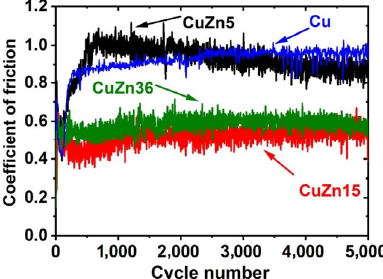
Fig. 1 COF as a function of the cycle number during the non- lubricated reciprocating sliding of Si 3 N 4 spheres on pure copper and  -brass samples with 5, 15, and 36 wt% zinc for a total of 5,000 cycles. The sliding velocity was set to 0.5 mm/s, the applied normal load to 2 N, and the stroke length was 12 mm. The relative humidity was kept at 50% and temperature at 20 ° C.